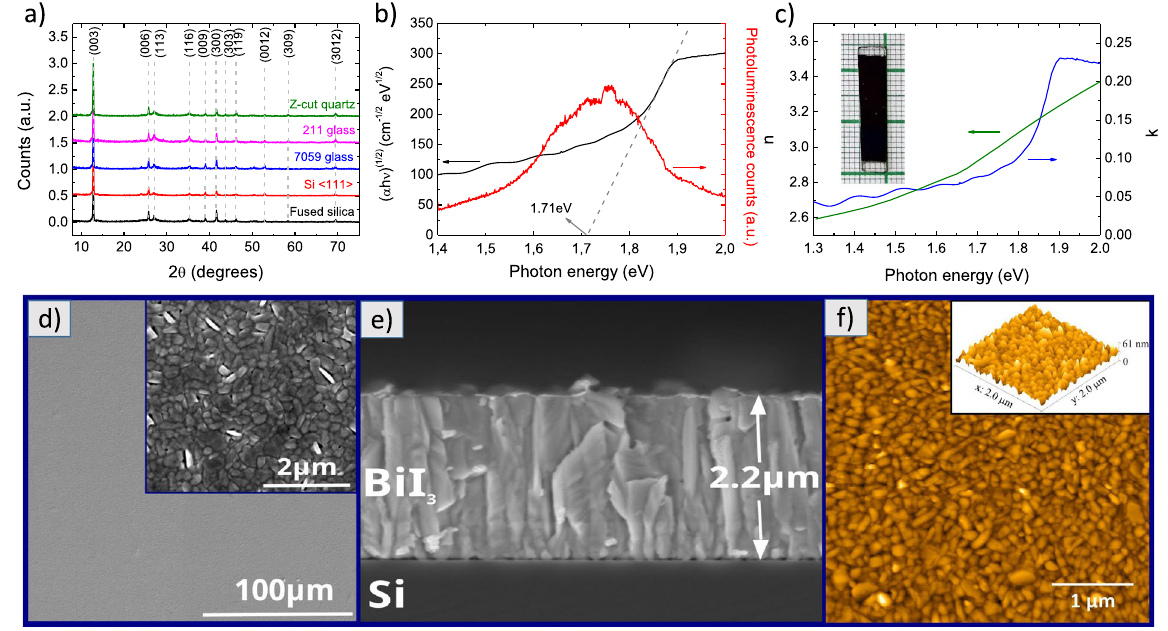
Figure 1. ( a ) X-ray diffraction pattern of bismuth triiodide thin films deposited on Z-cut quartz, 211 Precision glass, 7059 Corning glass, 〈 111 〉 silicon and fused silica (normalized at (003) peak). ( b ) Tauc’s plot (black) and photoluminescence spectra (red) of BiI 3 thin films (the extrapolation of the curve to ( α h ν ) 1/2 = 0 and the center of the photoluminescence emission gives an estimated band gap of 1.71 eV and 1.74 eV, respectively). ( c ) Refractive index and extinction coefficient as a function of photon energy (the inset is a photo of a sample − 25 mm × 5 mm in size). ( d , e ) Scanning electron microscope images of top view and cross section of BiI respectively and ( f ) AFM